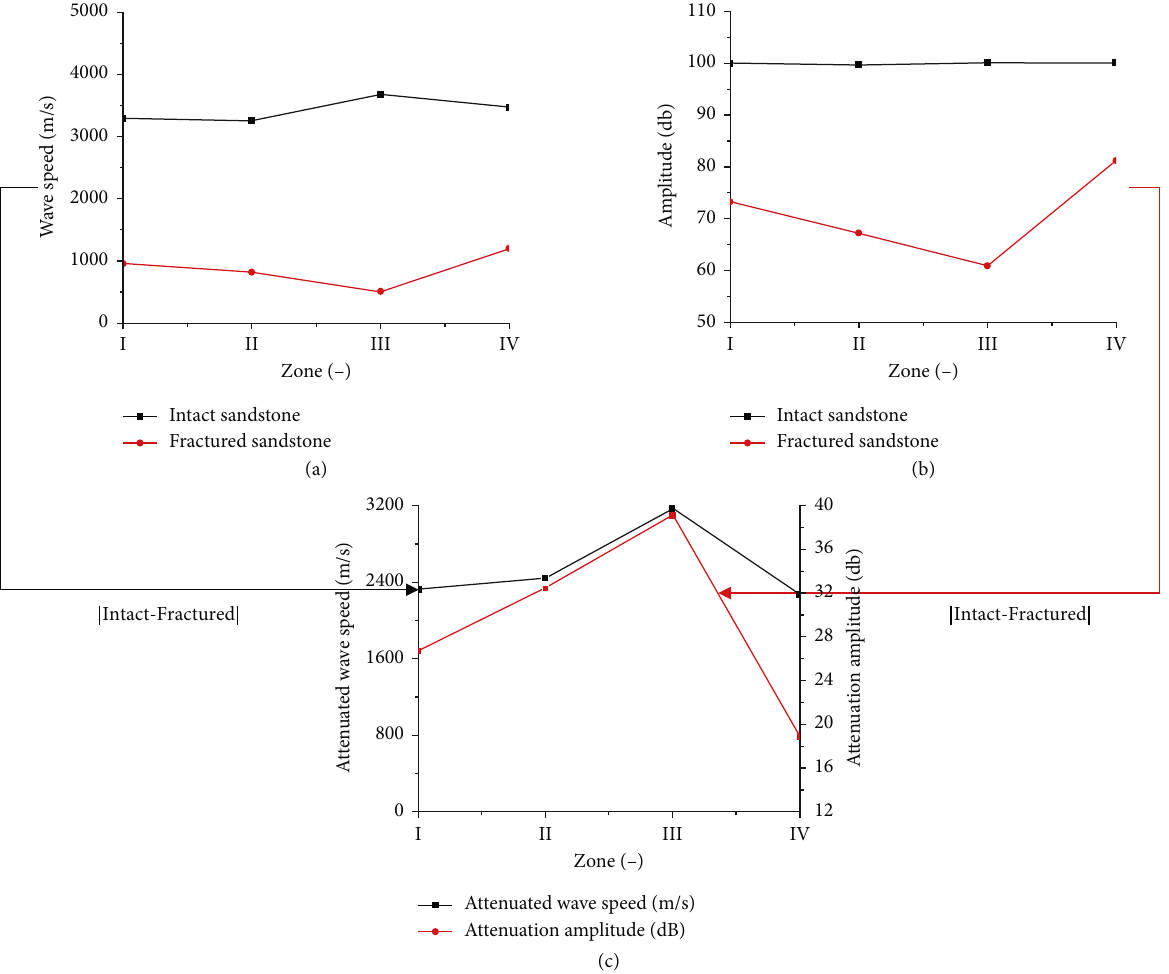
Figure 9: Attenuation contrast.(a) Wave speed comparison. (b) Amplitude comparison. (c) Attenuation trend.